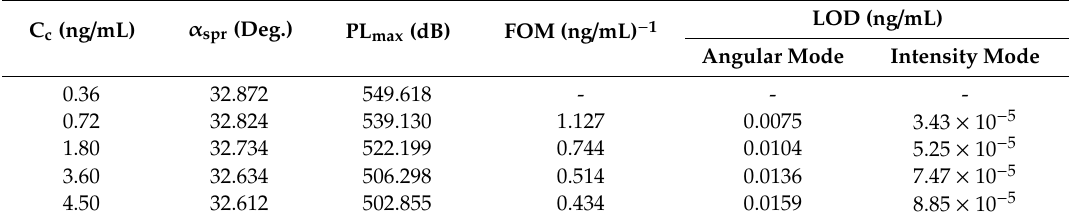
Table 5. Gratings and ZBLAN fiber